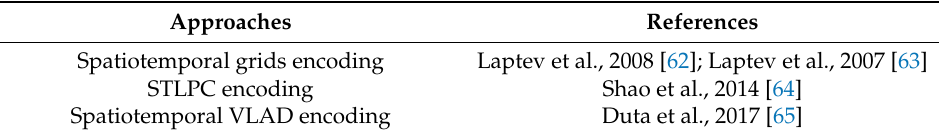
Table 2. Popular approaches and corresponding references for 3D